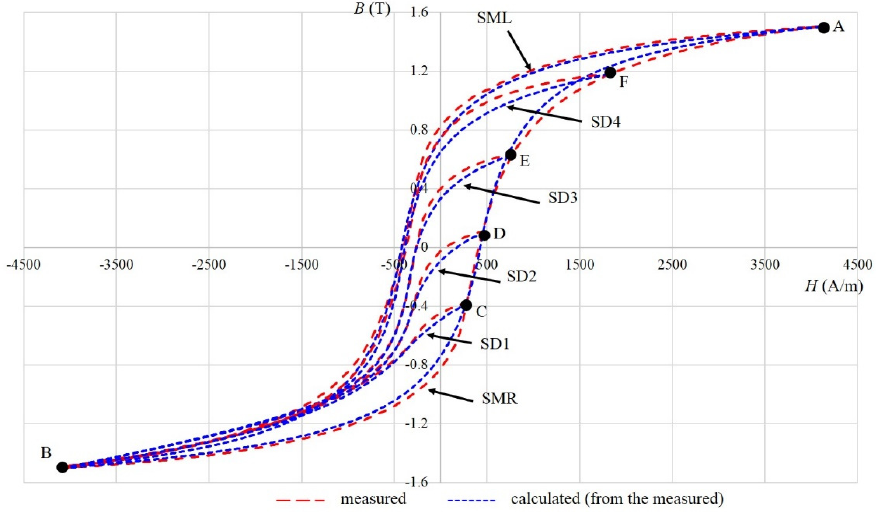
Figure 9. Measured and calculated major hysteresis loop (SML and SMR) and first-order decreasing reversal curves (SD1–SD4).